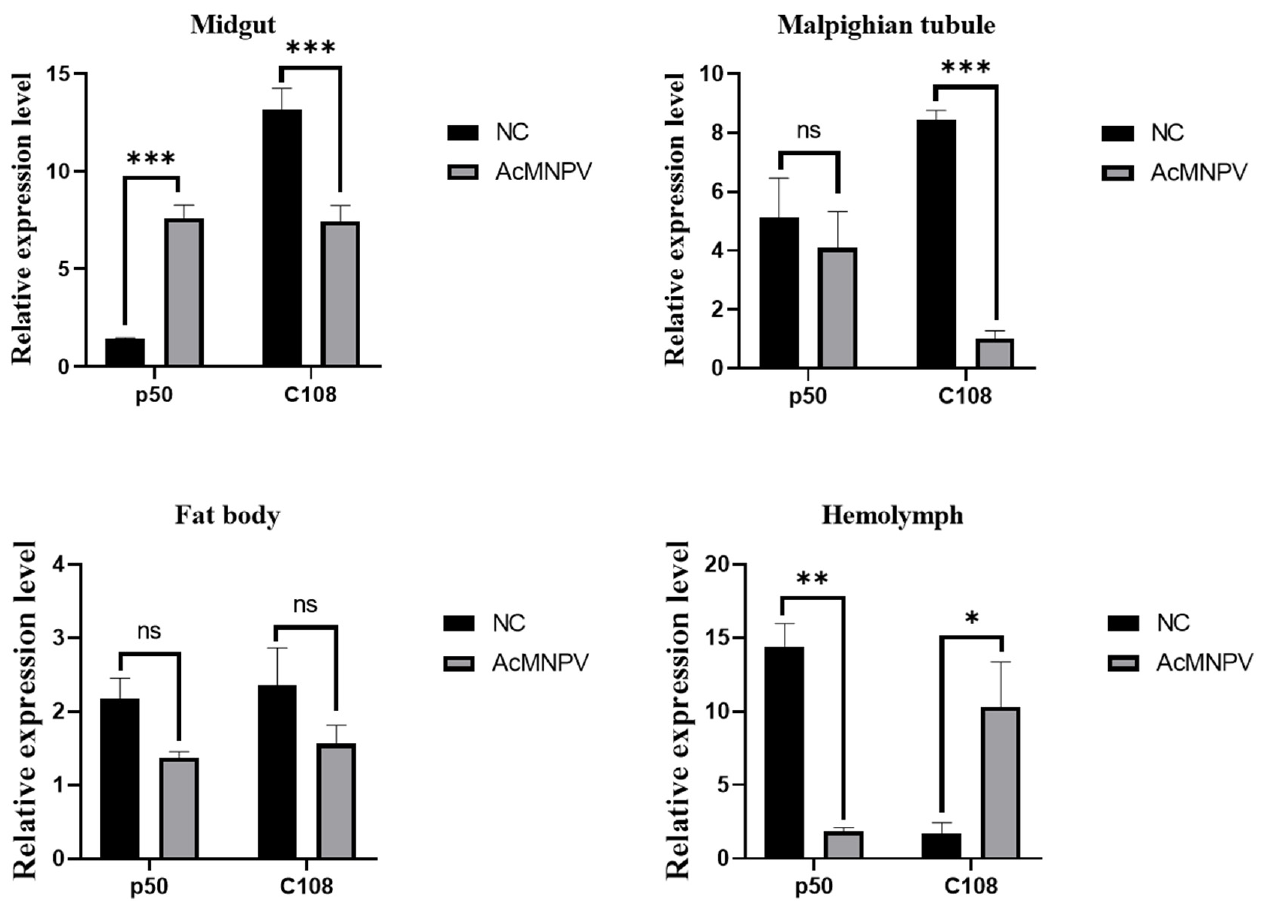
Figure 7. Analysis of BmTex261 expression levels in different tissues among different resistant strains following AcMNPV infection using RT-qPCR. NC is the negative control. BmGAPDH was used to normalise the data that are shown as the mean ± standard error; the mean was obtained from three independent repeats. The 2 − ∆∆ Ct method was adopted to calculate the relative expression level. The statistical difference among three biological duplicates, determined with one-way ANOVA, is shown via graphpad prism. The level of statistical significance was set at ns, p > 0.05, *, p < 0.05; **, p < 0.01; and ***, p < 0.001.